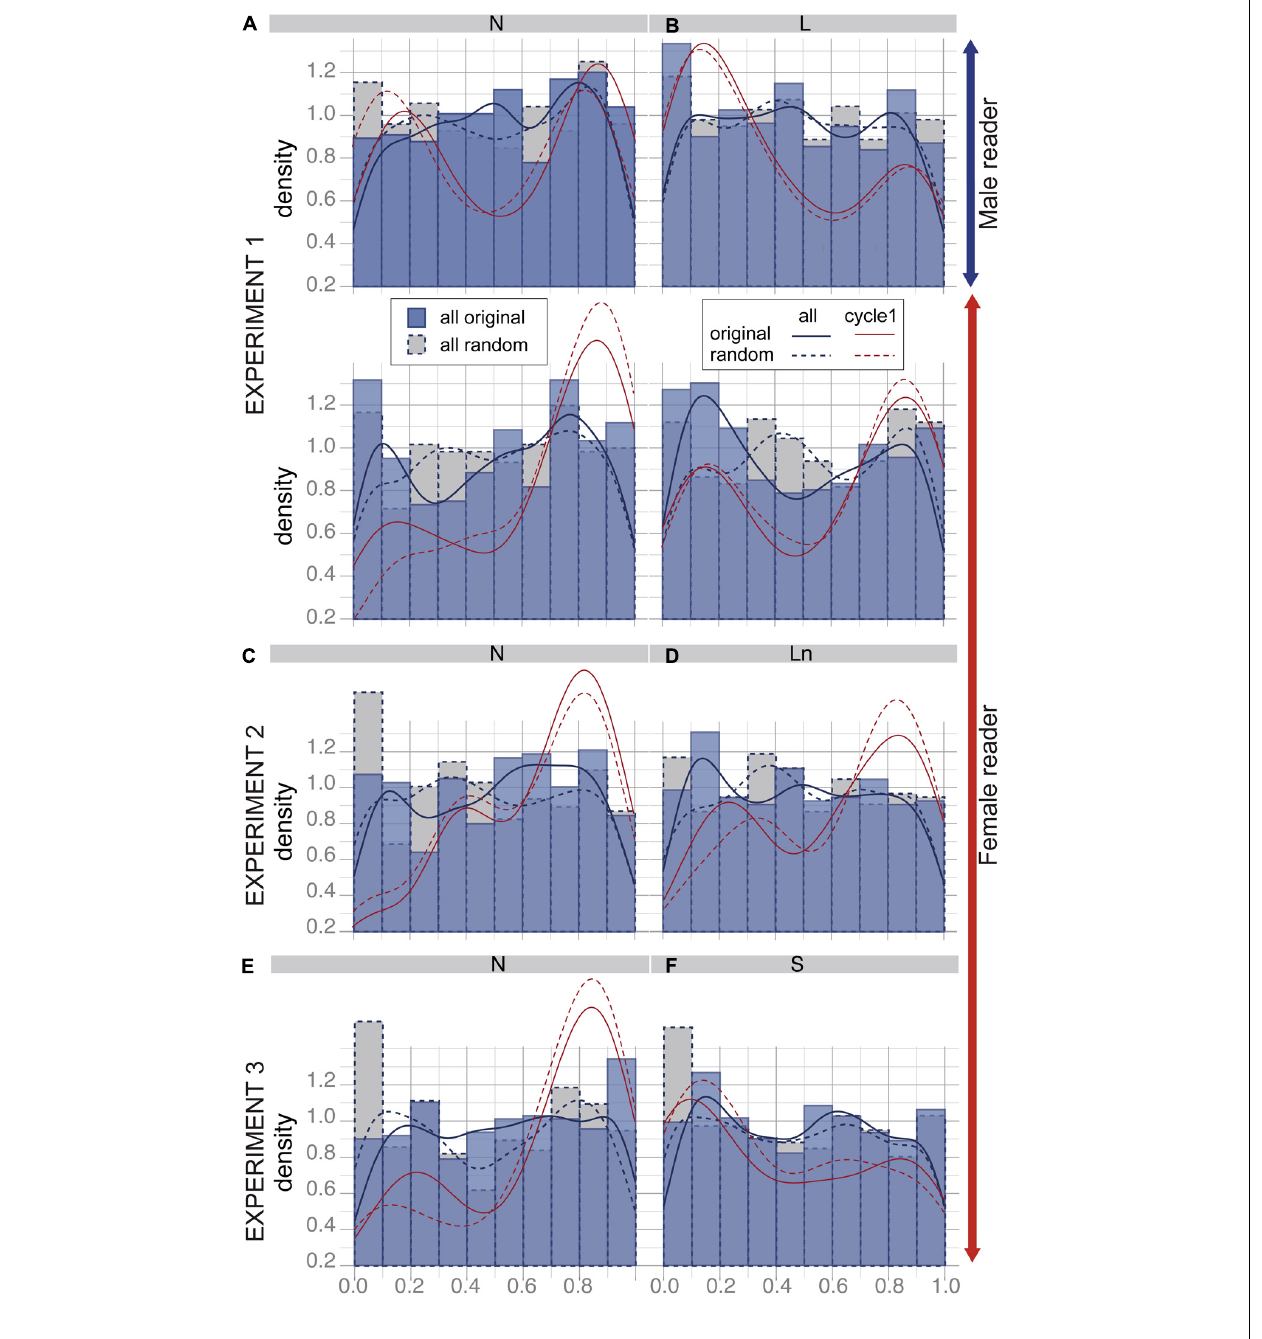
first cycle of each trial (red), for original associations (straight line) and random associations (dotted lines). A,C,E : Results for the normal condition in Experiment 1, Experiment 2, and Experiment 3 respectively; B : results for Experiment 1, loud speech; D : Experiment 2, loud speech normalized in amplitude, F : Experiment 3, slow